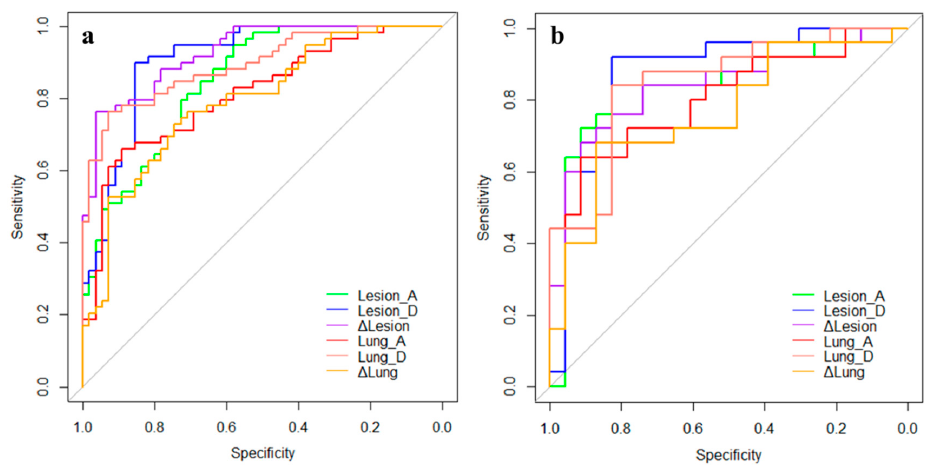
Figure 4. The ROC curves of the six prediction models in the training set ( a ) and the test set ( b ). In both the training and test sets, the predictive performances of the models based on discharge CTs are higher than those of the models based on admission CTs, and the predictive performances of the models based on lesions are higher than those of the models based on total lung.